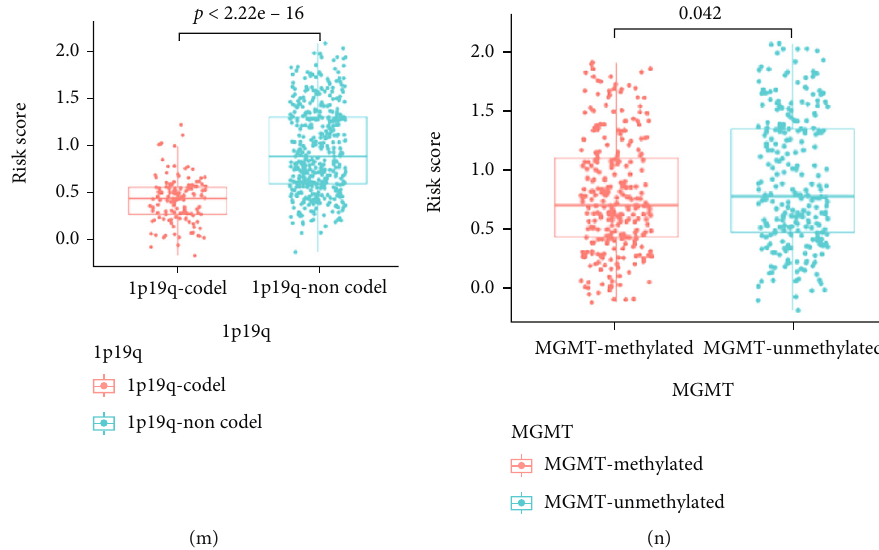
Figure 6: The risk score in di ff erent subgroups is divided by clinical features in TCGA and CGGA cohorts. Survival analyses using IGGR signature in patients with di ff erent (a, g) ages, (b, h) gender, (c, i) grade, (d, j) IDH, (e, k) radiotherapy, (f, l) chemotherapy, (m) 1p19q status, and (n) MGMT